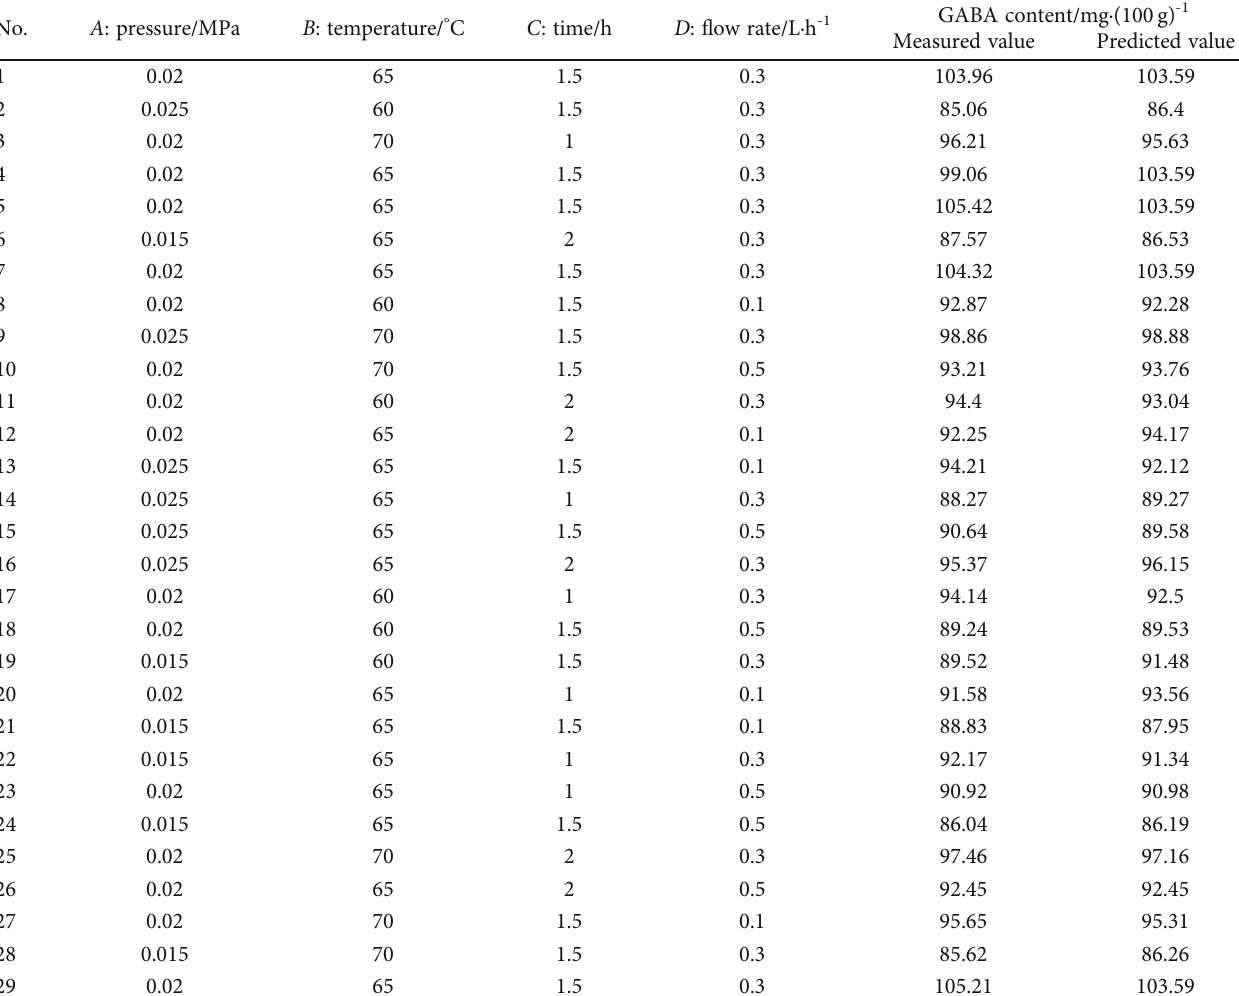
Table 5: Analysis scheme and results of the drying response surface of low-pressure overheated steam.